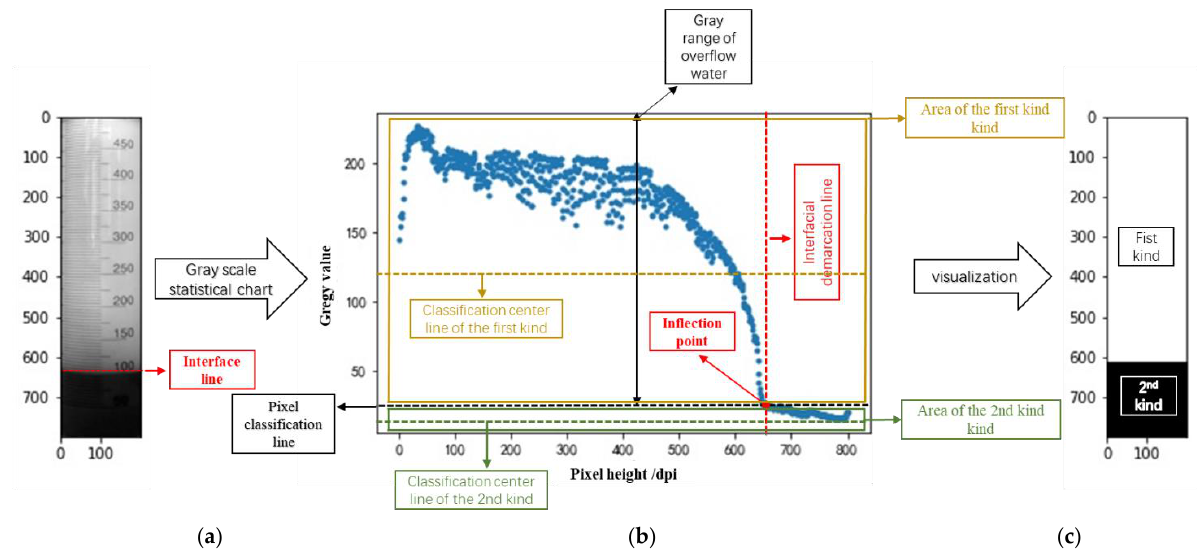
Figure 5. Determination of gray scale range of overflow water. ( a ) original image; ( b ) gray statistical chart; ( c ) visualization of classification results.